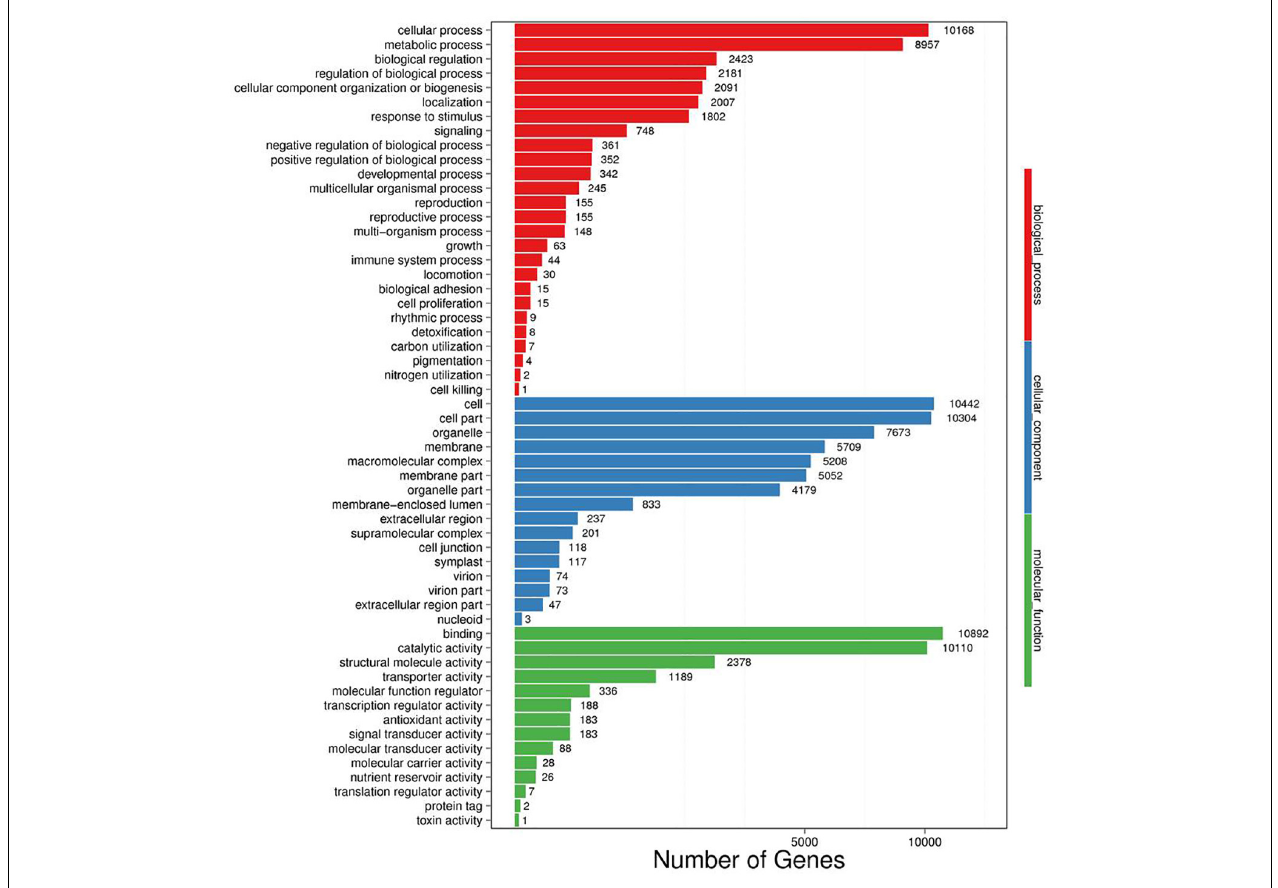
FIGURE 5 | Gene ontology enrichment analysis of differentially expressed genes between 0 (control) and 150 mM NaCl- treated Puccinellia nuttalliana